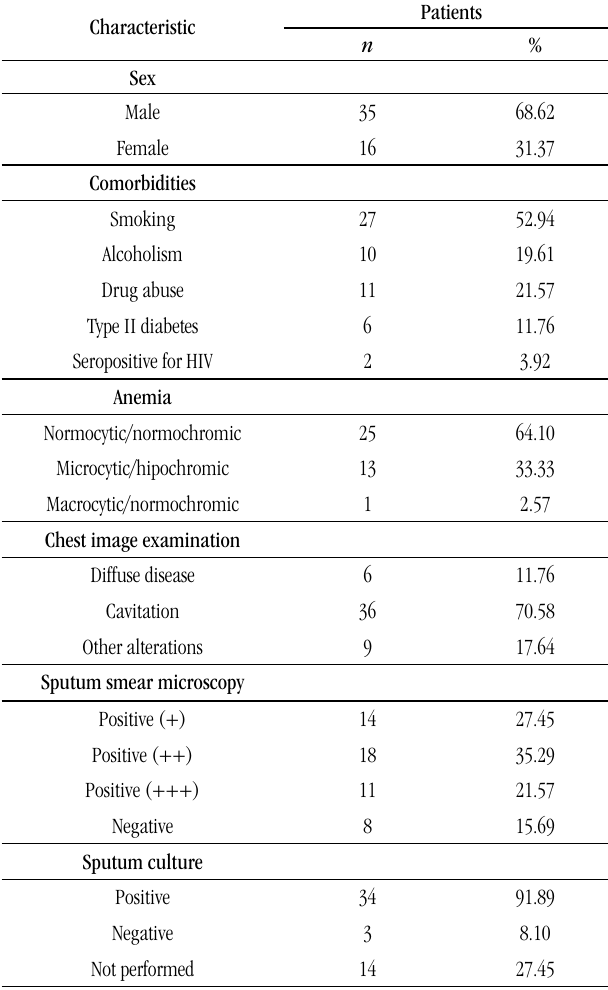
tABLE 1 – Clinical and laboratorial characterization of 51 patients of the study at T0